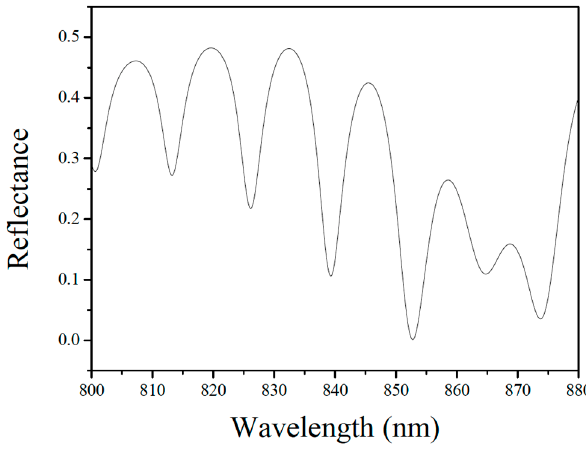
Figure 5. Simulated reflection spectrum of the sensor.